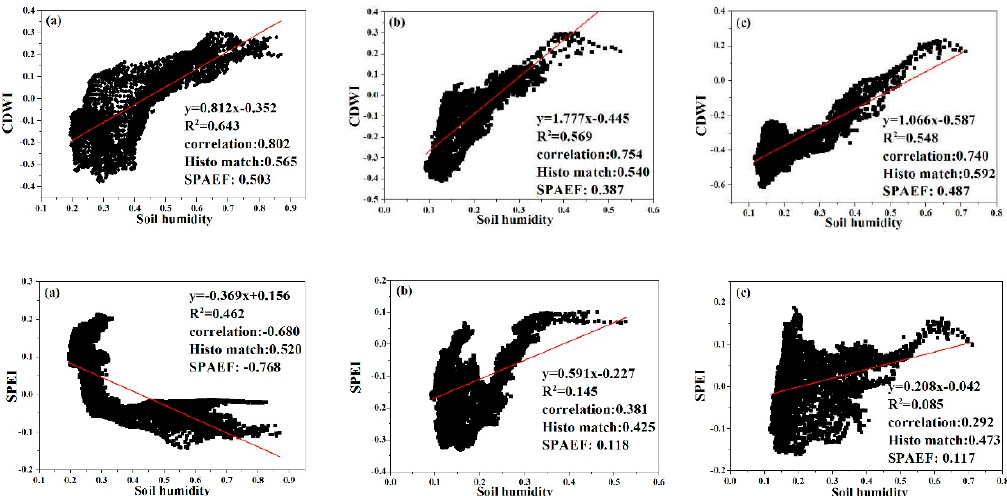
Figure 5. Scatter plots comparing spatial patterns between CDWI, SPEI, and soil humidity. Scores for the SPAEF components (histogram matching and correlation) are given in the graphs at different stages in Midwestern Jilin Province. ( a – c ) Represent the stages of emergence-tasseling stage, tasseling-milky maturity, and milky maturity-mature, respectively.